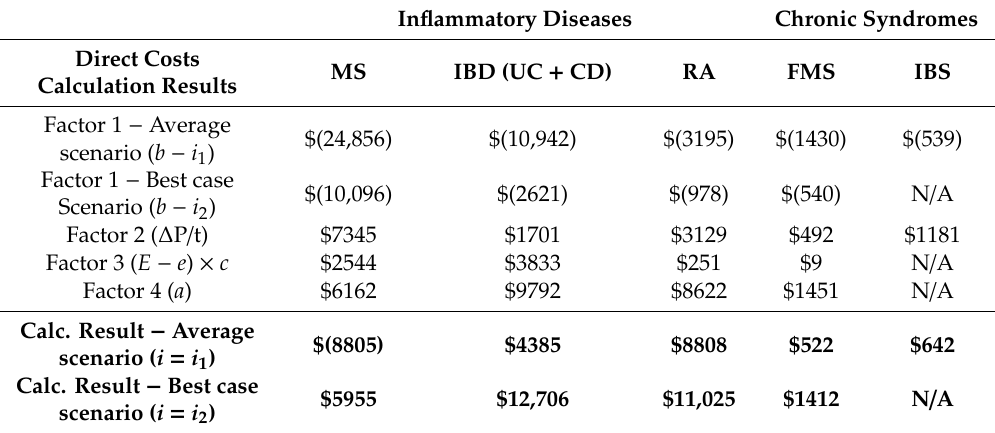
Table 3. Results of financial analysis equation for average and most cost-e ff ective treatment